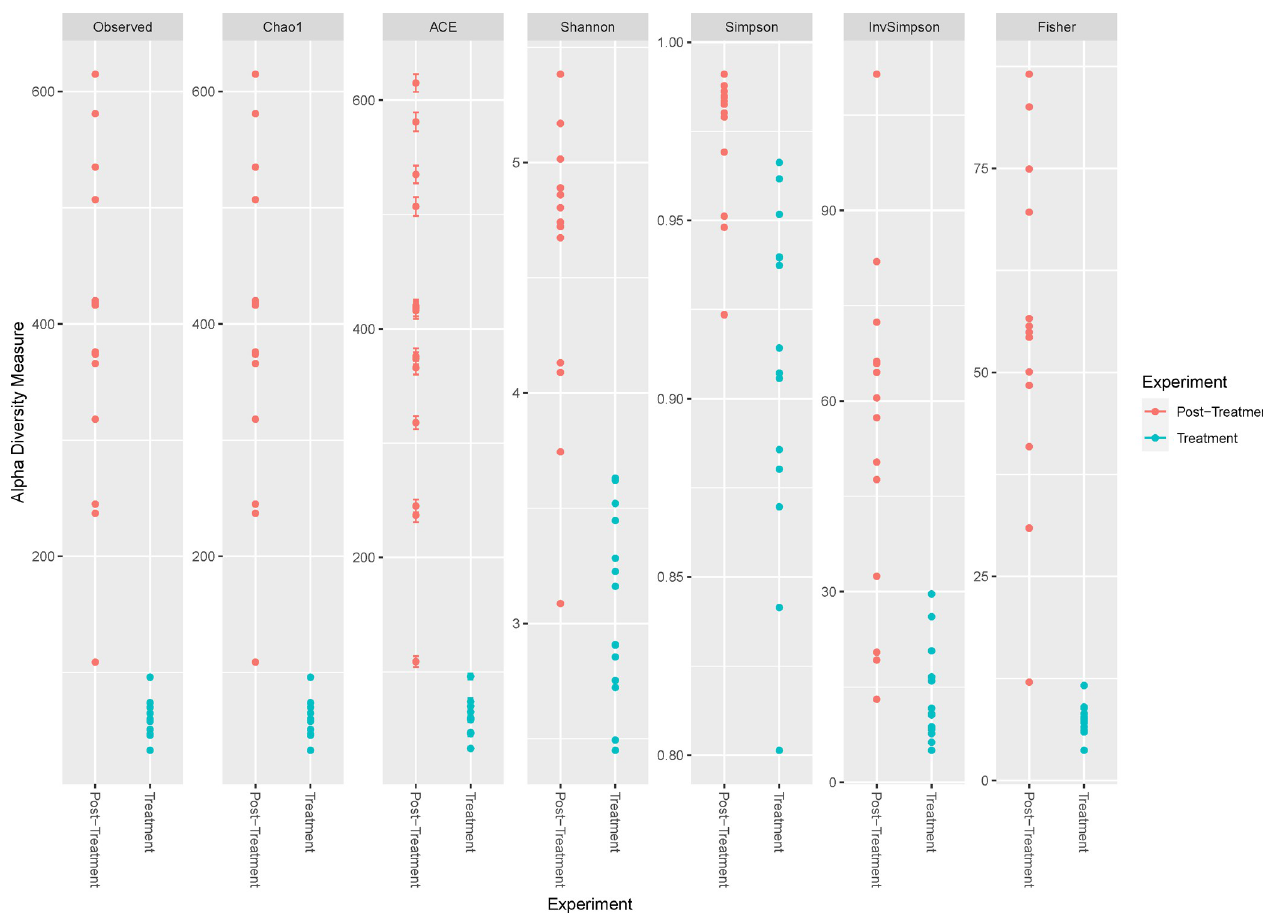
Fig 6. Species diversity measures of the bacterial community in fawn-footed mosaic-tailed rat ( Melomys cervinipes ) faecal samples. For rats treated with antibiotics (TREATMENT) and more than one year later (POST-TREATMENT).